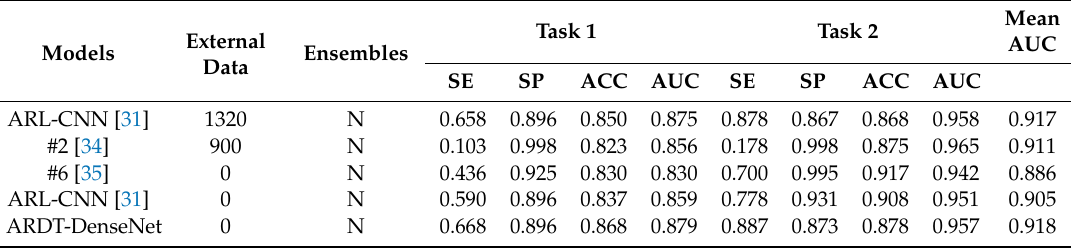
Table 6. ARDT-DenseNet compared with state-of-the-art models and top-ranking models in ISIC 2017.